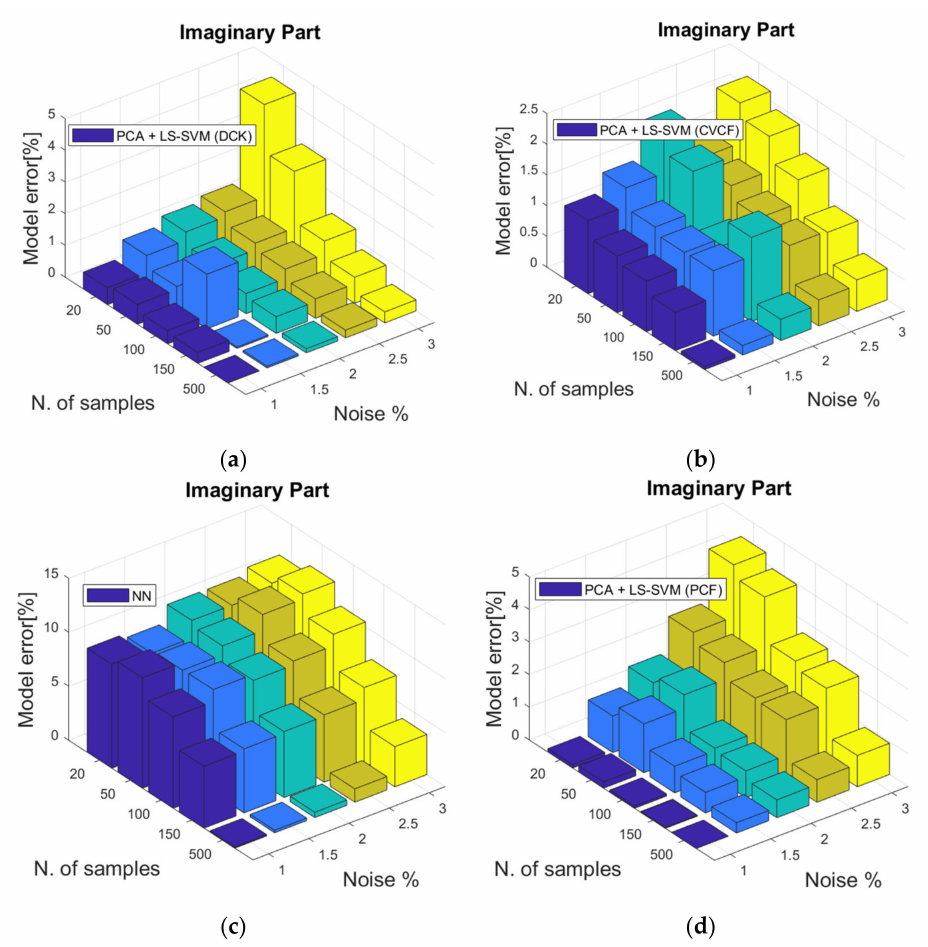
Figure 9. Three-dimensional plot of the relative NRMSE computed on the real part of the test samples at a single frequency point selected as the one providing the maximum error via the proposed approaches (see panel ( a ) for the DCK, panel ( b ) for CVCF and panel ( d ) for PCF), and a multi-output feedforward NN (see panel ( c )) for different values of the noise standard deviation σ n and the number of training samples